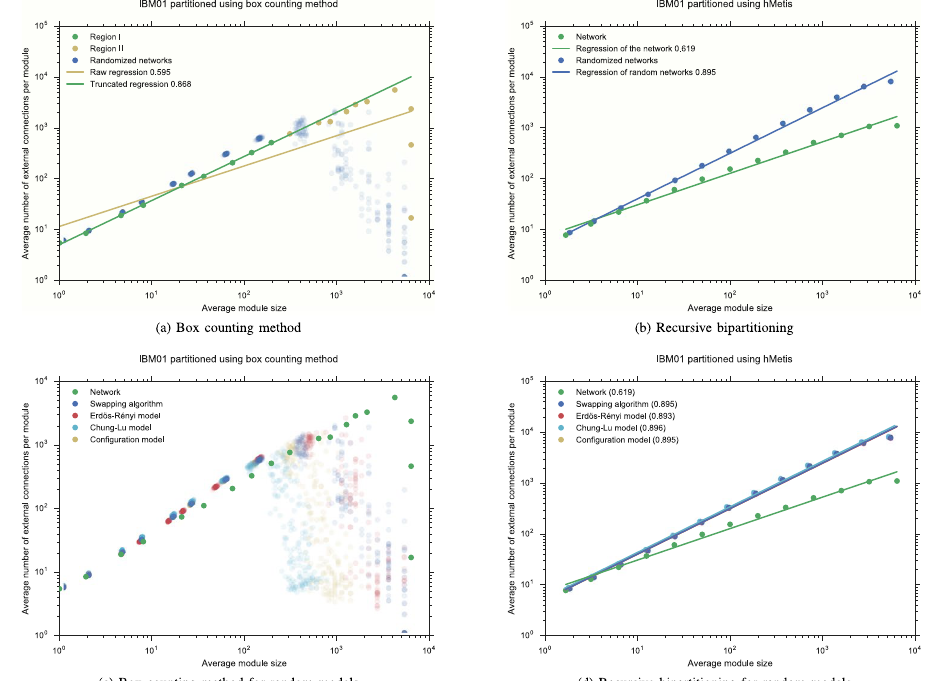
Figure 5. ( a , b ) Rent characteristics of the ISPD98 circuit ibm01 with 12,752 nodes and 50,566 edges, which are obtained using the box counting method and recursive bipartitioning. ( c , d ) Rent characteristics for randomized networks derived from the ISPD98 circuit